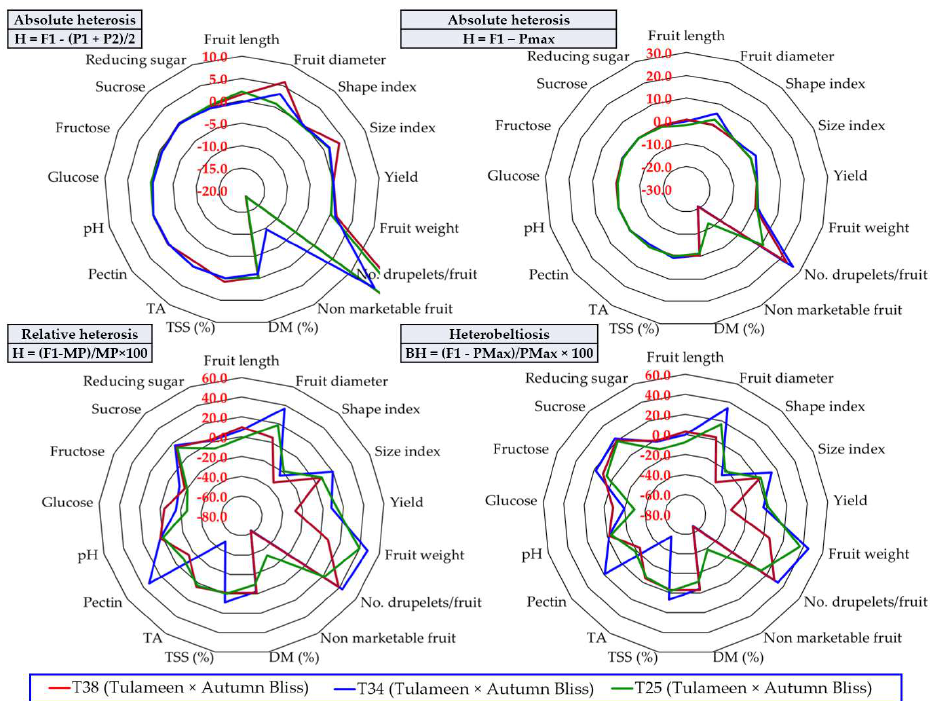
Figure 6. The heterosis effect upon the 17 analyzed characteristics in three promising selections obtained from the hybridization of Tulameen × Autumn Bliss.